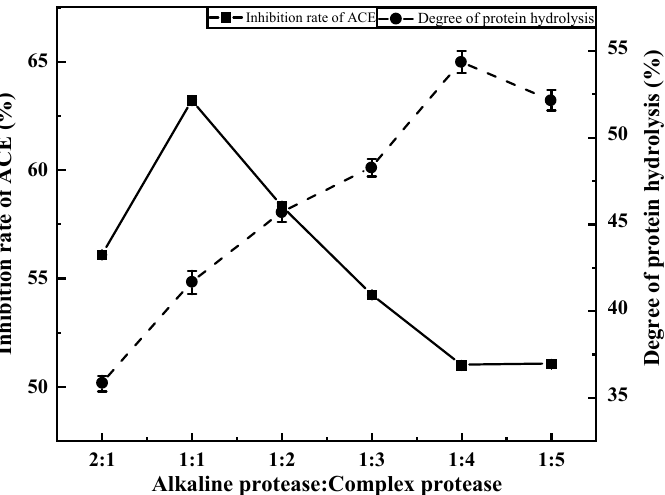
Figure 3. Effect of the addition ratio on the degree of protein hydrolysis and the inhibition rate of ACE.